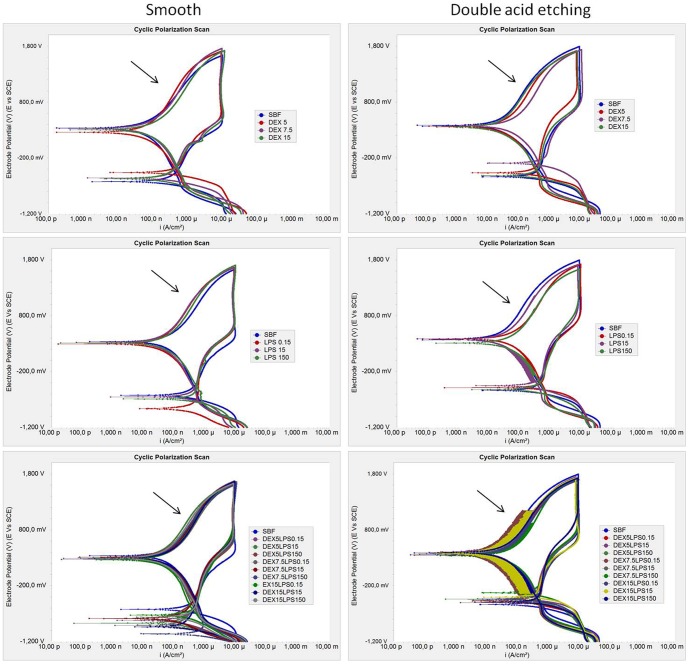
Representative cyclic potentiodynamic polarization curve of Ti-6Al-4V alloy.Tests were conducted in simulated body fluid - SBF (control) with different concentrations of dextrose (DEX), lipopolysaccharide (LPS), and combinations of dextrose and lipopolysaccharide (DEXLPS).